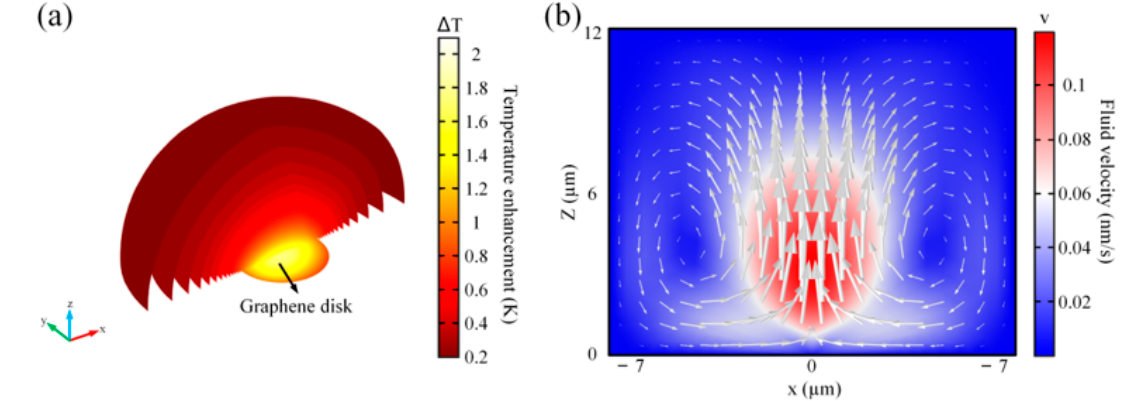
Figure 5 . ( a ) Heat power dissipation density Around the graphene disk, ( b ) the steady-state fluid velocity and fluid vector under the incident light intensity I 0 = 1 mW/ µ m 2